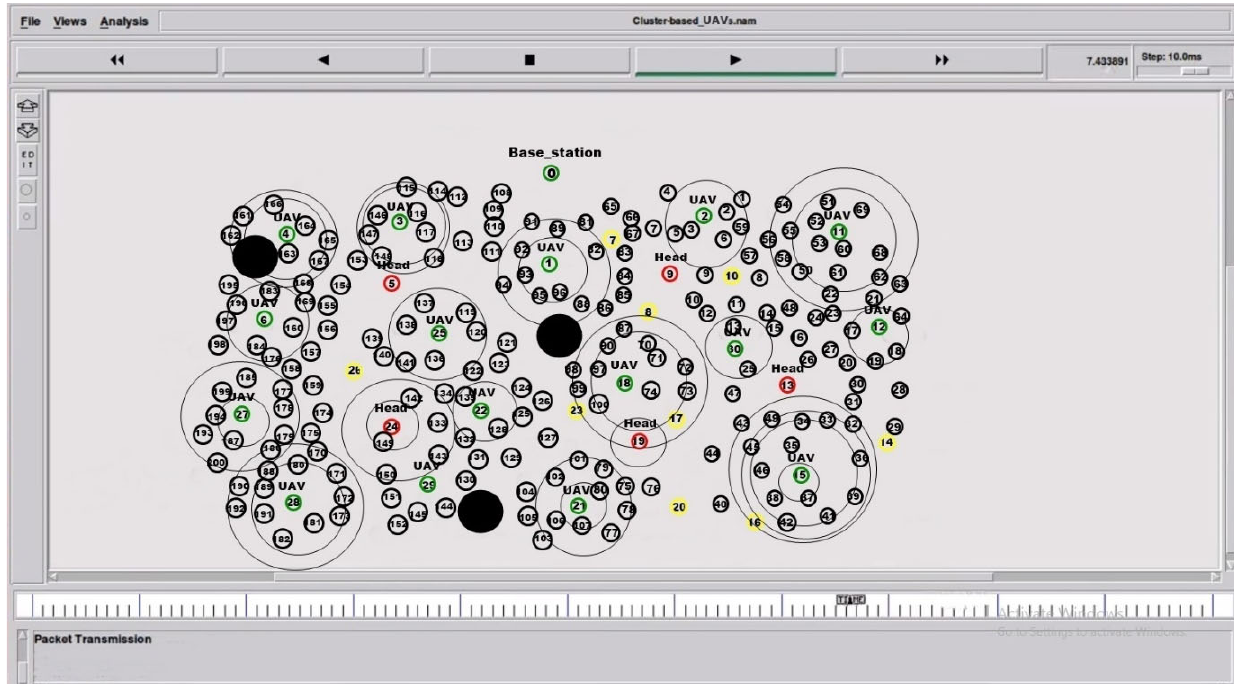
Figure 8. Final result without obstacles.